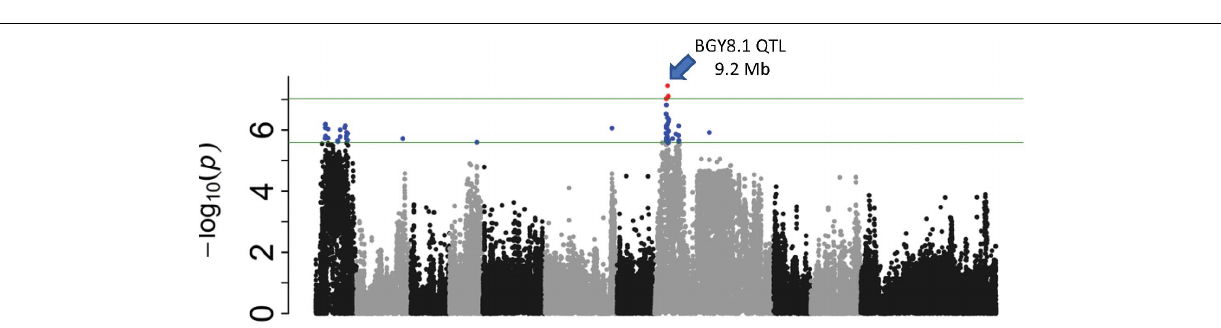
Frontiers in Plant Science |